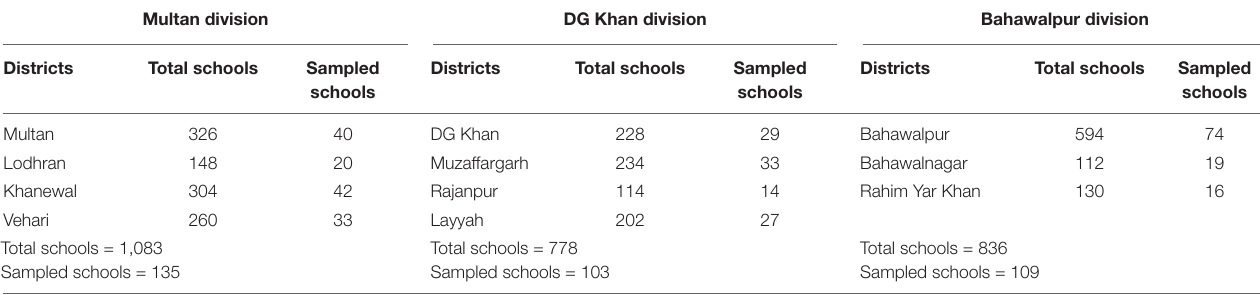
TABLE 1 | District wise categorization of total schools and sampled schools.